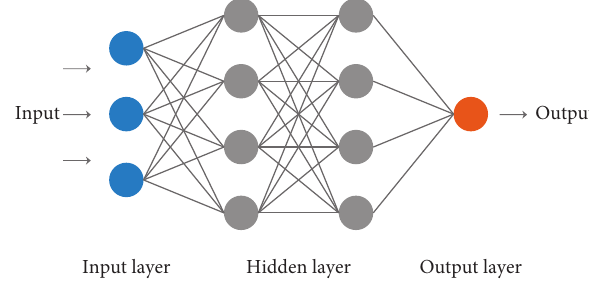
Figure 1: Architecture of